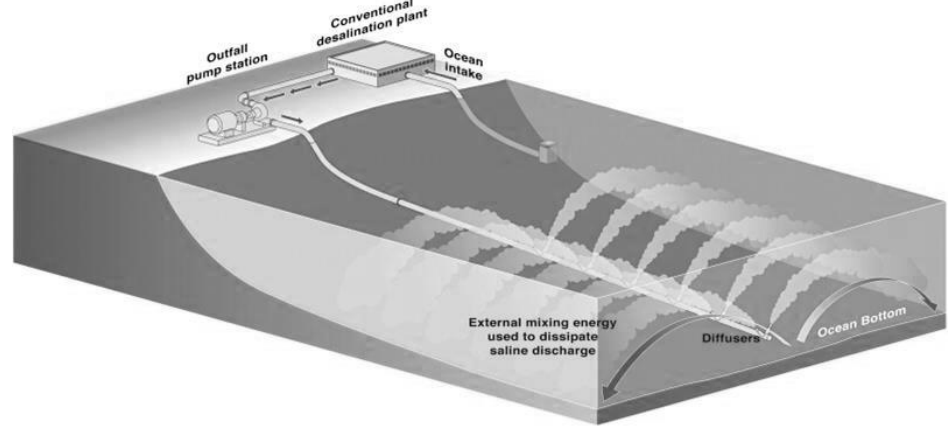
Figure 1. Schema of a brine discharge system at a desalination plant [2].